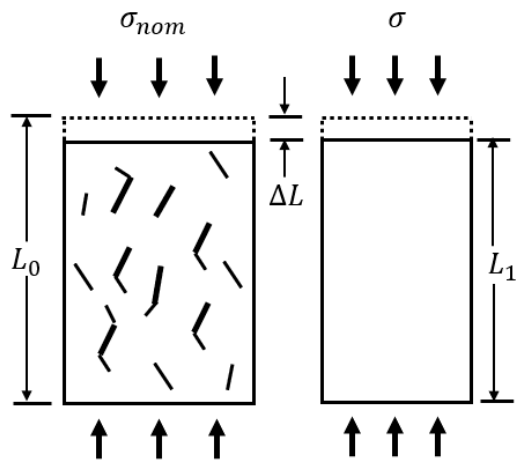
Figure 6. The strain equivalence hypothesis diagram.